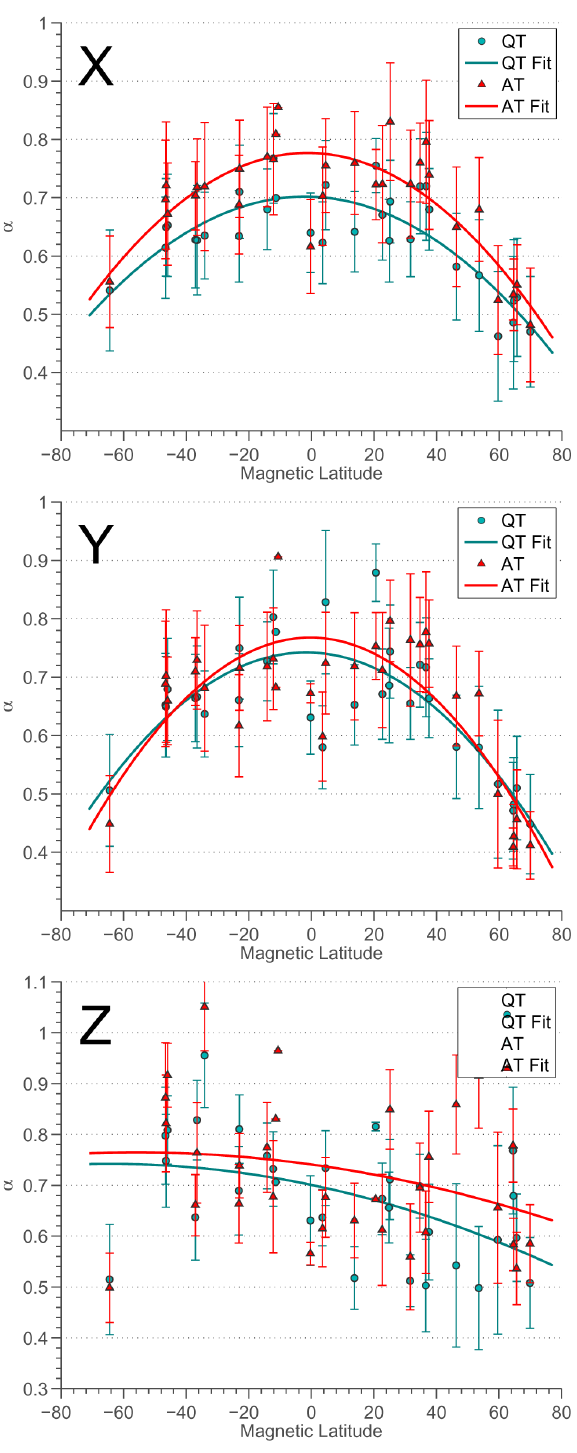
Fig. 6. Fractal scaling exponent for quiet (magenta circles) and ac- tive (red triangles) events as a function of latitude for different com- ponents of the magnetic field. The best-fit polynomials are shown in red (active) and magenta